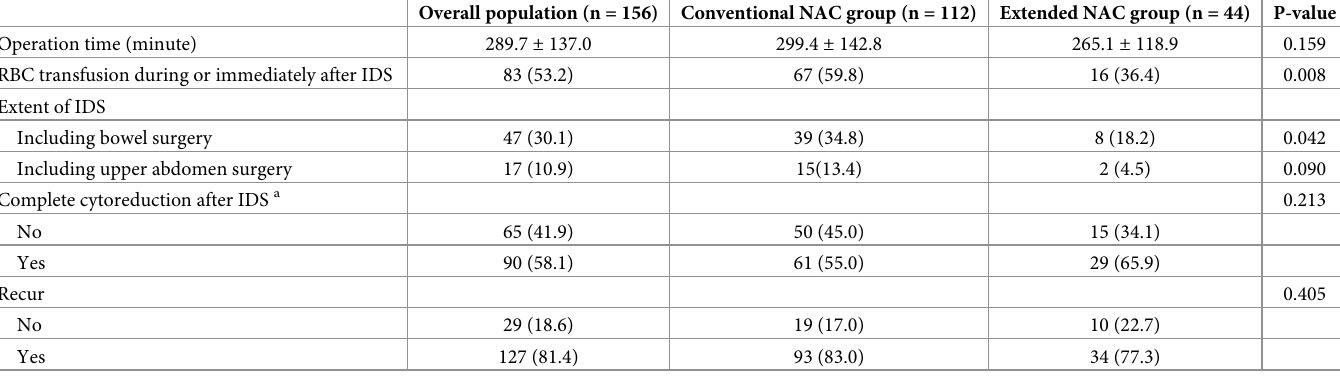
Values are presented as number of patents (%) or mean ± standard